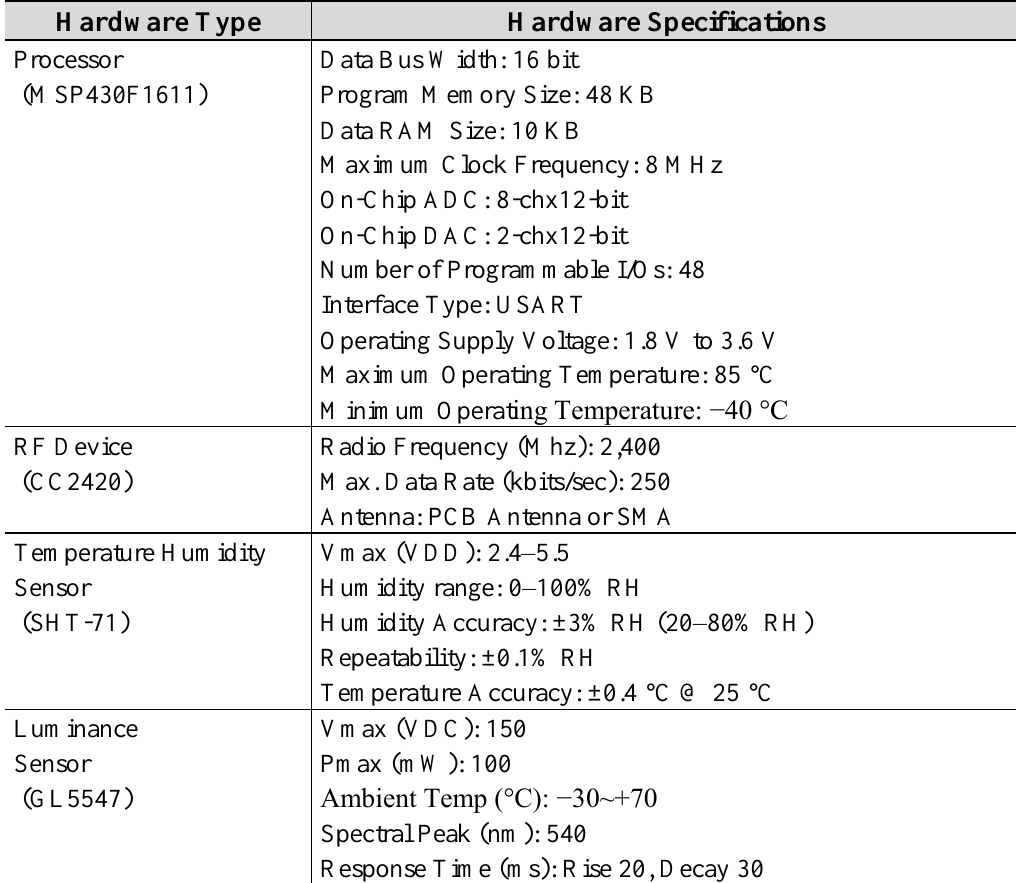
Table 1. Hardware type and specifications of WSN Environmental Sensor Nodes.